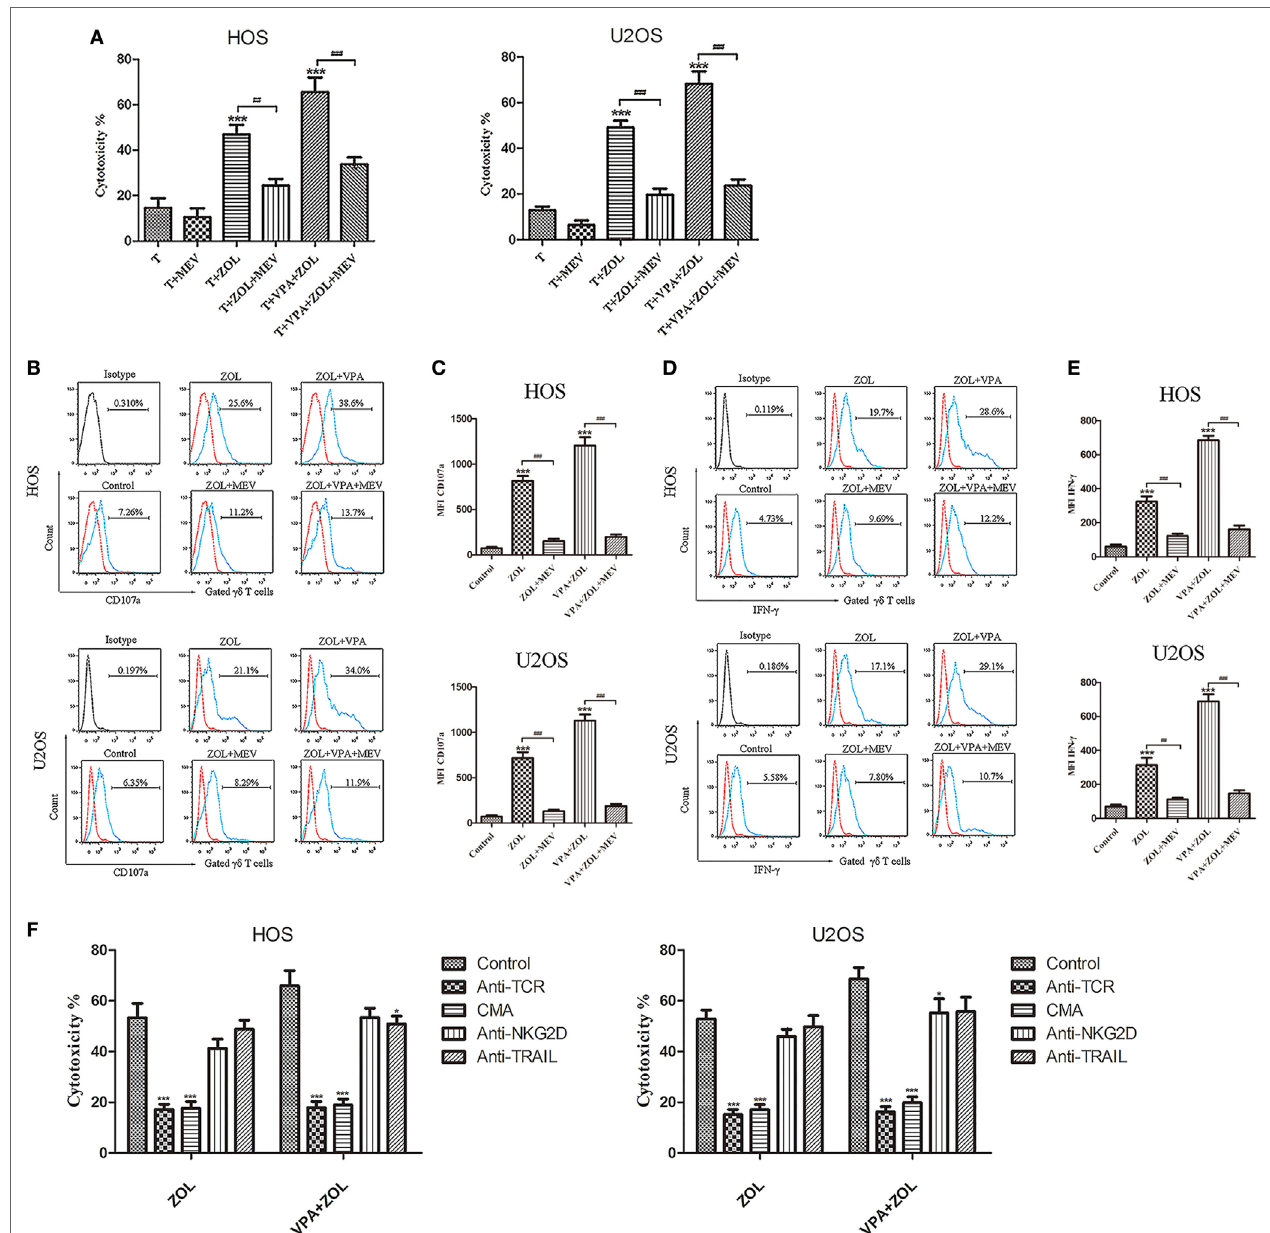
FigUre 4 | Mechanisms of the antitumor efficacy of γδ T cells induced by valproic acid (VPA) and zoledronate (ZOL). Osteosarcoma cells were pre-treated with 5 µM MEV 1 h prior to incubation with control or VPA or/and ZOL for 24 h. Then tumor cells were co-cultured with γδ T cells for 2 h at an E:T ratio of 5:1. (a) γδ T cells cytotoxicity against osteosarcoma cells was determined by MTS assay. The cytotoxic effect of γδ T cells induced by VPA and ZOL could be significantly inhibited by MEV (B,c) CD107a expression levels were evaluated by flow cytometry. MFI of CD107a + γδ T cells was presented in histograms. (D,e) IFN- γ expression levels were evaluated by flow cytometry. MFI of IFN- γ + γδ T cells was presented in histograms. (F) γδ T cells cytotoxicity was significantly inhibited in the presence of blocking Abs against TCR or concanamycin A (CMA), and partly reduced by blocking NKG2D or TRAIL. Red histogram line was isotype control and panels were overlapped. All the values were shown as mean ± SD from three separate experiments; * p < 0.05, *** p < 0.001 versus control [T in (a) ], ## p < 0.01, ### p <